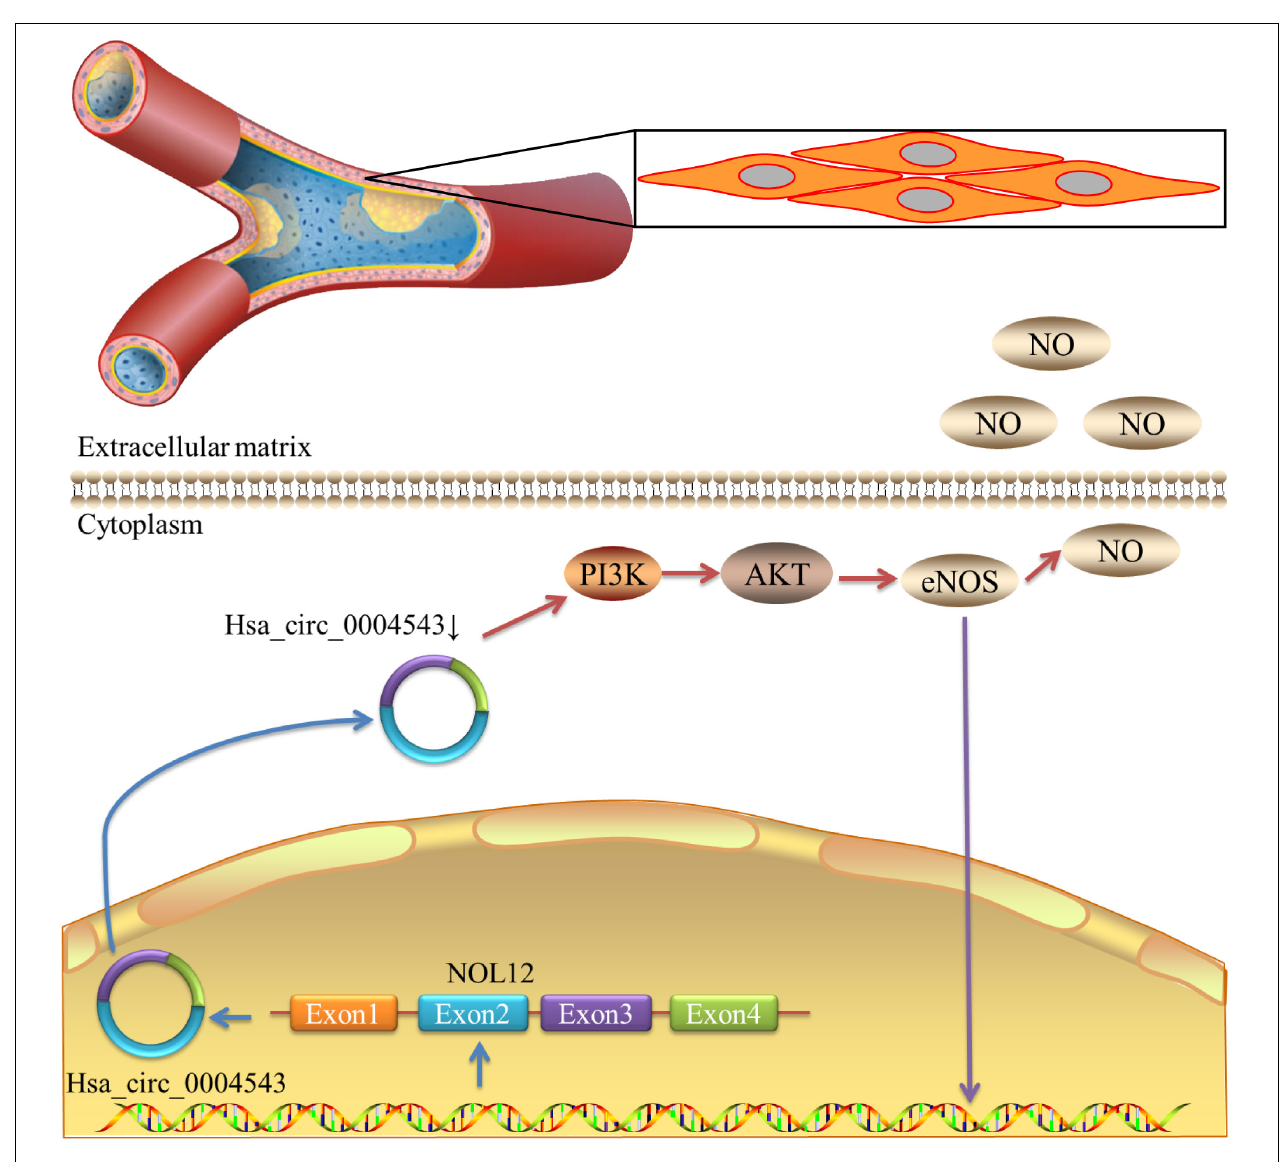
FIGURE 5 | Schematic diagram demonstrating that the decrease in hsa_circ_0004543 expression activates the PI3K/AKT/eNOS